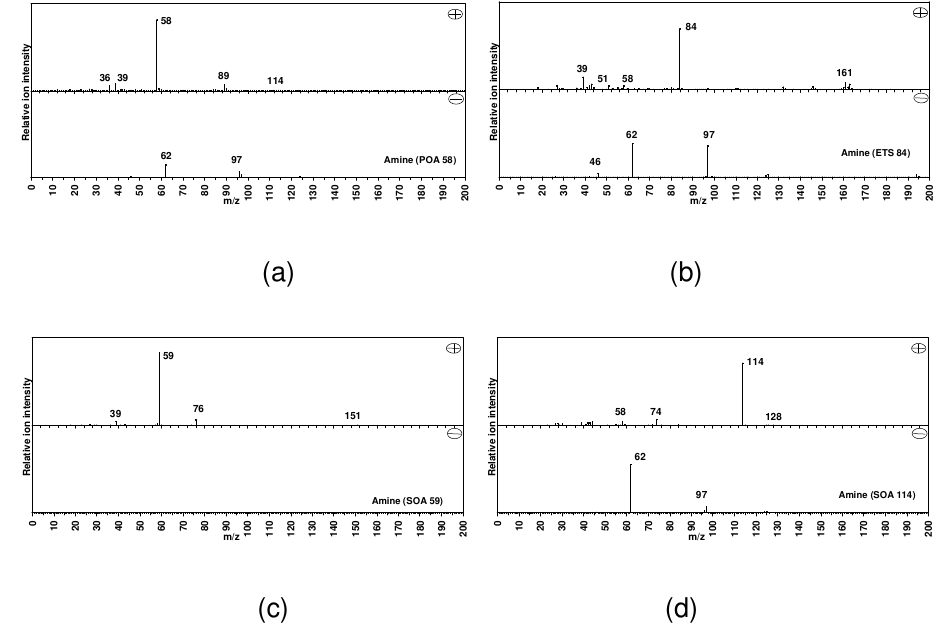
Figure 5. Average mass spectra of the four amine-containing single-particle types only observed at the RS site.